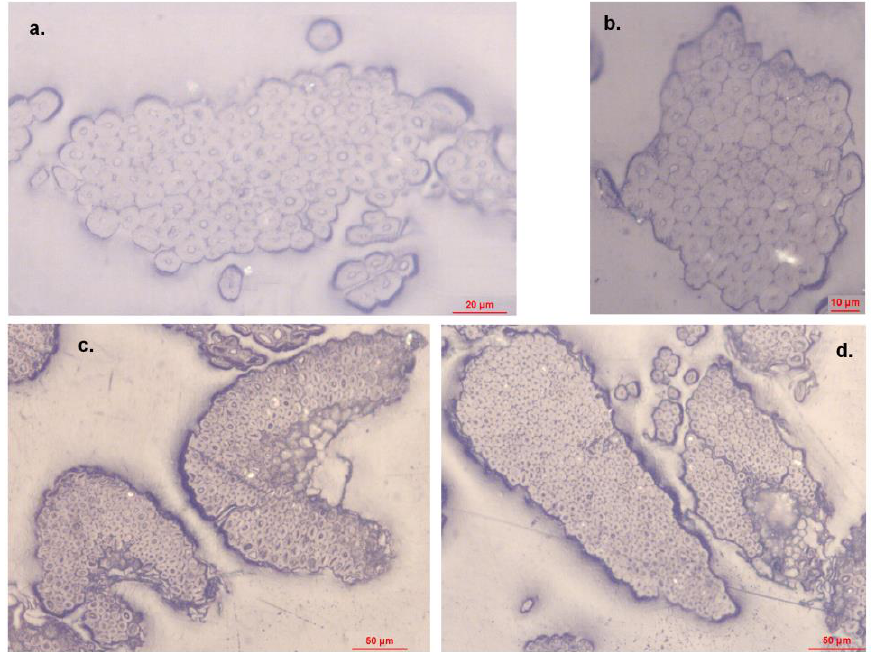
Figure 3. Different geometries of phormium fibers: ( a ) elongated, ( b ) quasi-circular, ( c ) keyhole, and ( d ) horseshoe.